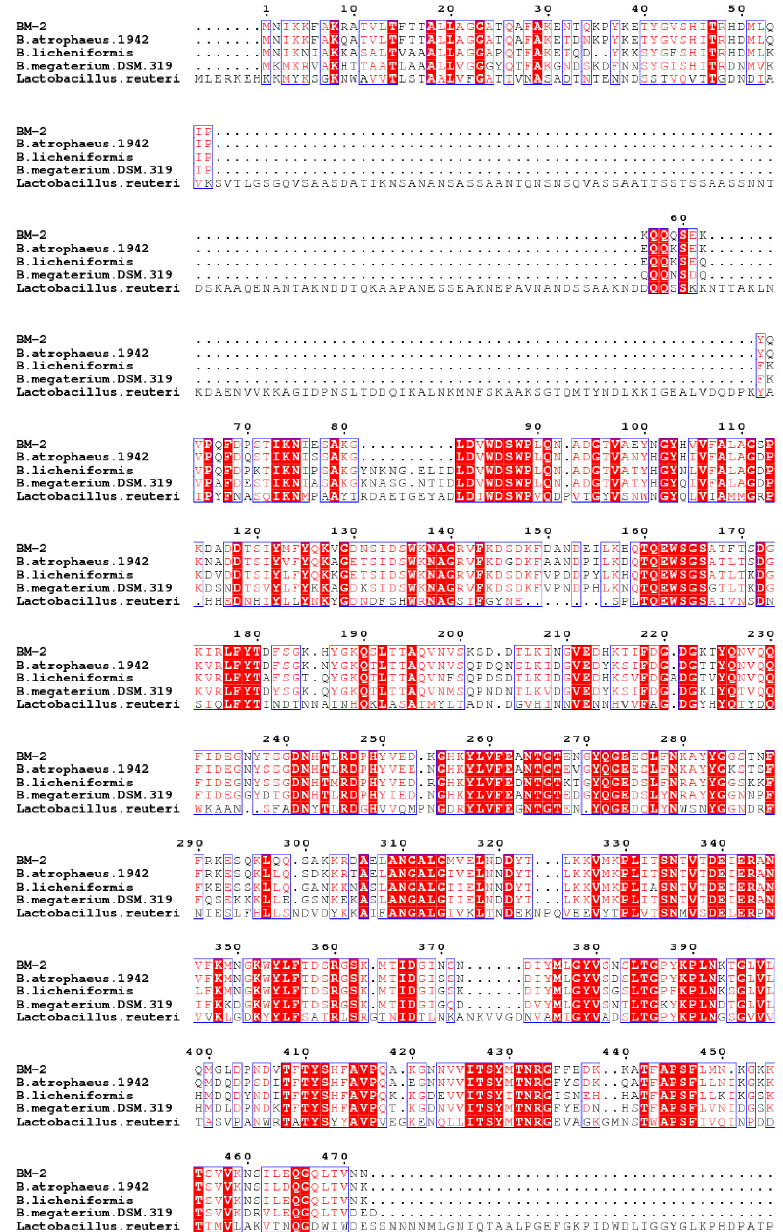
Figure 1. Sequence alignment of levansucrases from B. velezensis BM-2 and other levansucrases. Sequences were compared with the following enzyme/source/accession numbers: levansucrase, Bacillus atrophaeus 1942 (GenBank: ADP33953.1); levansucrase, Bacillus licheniformis (GenBank: ACI15886.1); levansucrase, Bacillus megaterium DSM 319 (GenBank: ADF38395.1); fructosyltrans- ferase, Lactobacillus LTH5448 (GenBank: CAH25436.2). The alignment was conducted using ClustalX and ESPript software. The strictly conserved areas are shown with a red background, and the highly conserved residues are shown using red words surrounded by a blue